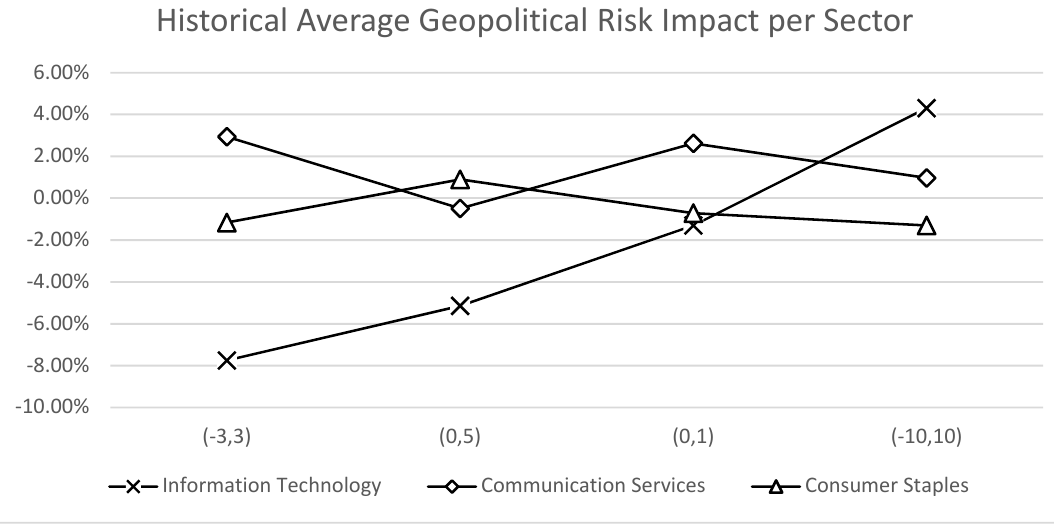
J. Risk Financial Manag. 2021 , 14 , x FOR PEER REVIEW Figure A2. Plot of cumulative abnormal returns for the “9/11” Geopolitical event and event window ( − 10,10).